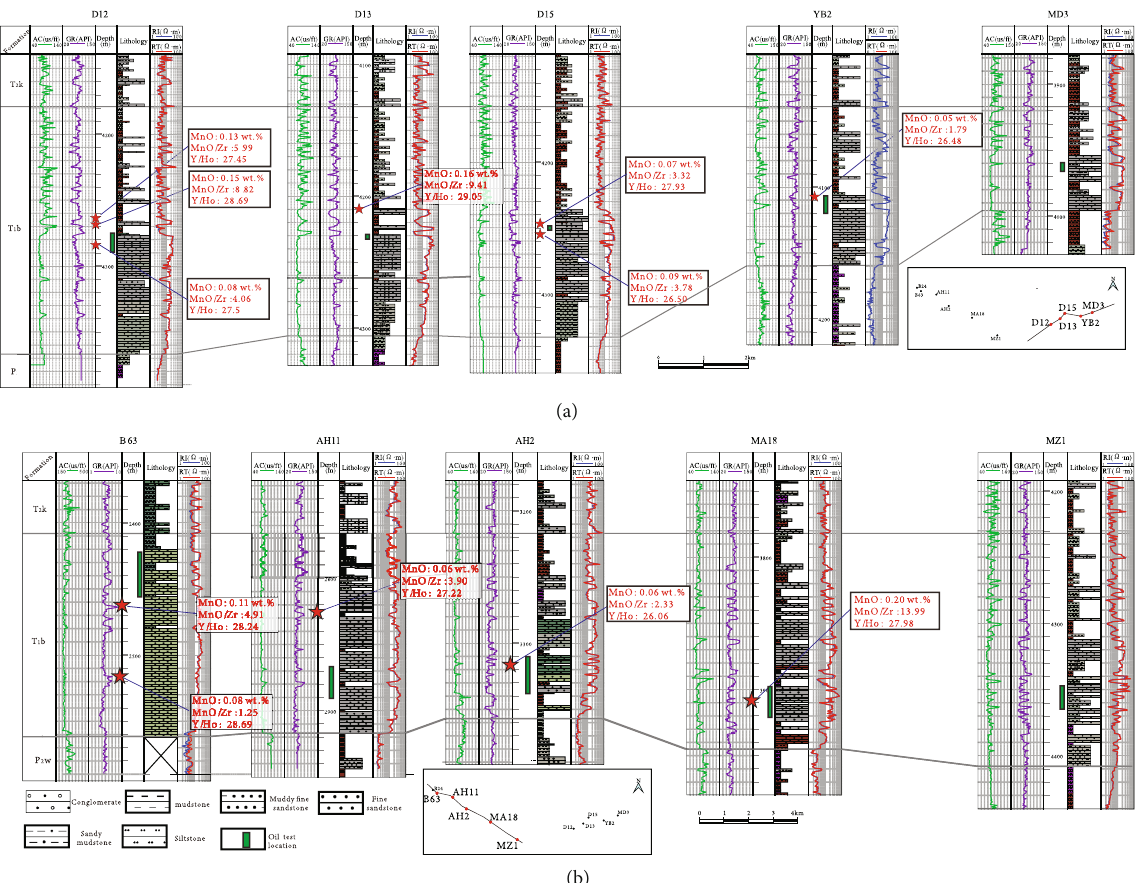
Figure 9: (a) D12-D13-D15-YB2-MD3 tracing indicators (MnO, MnO/Zr, and Y/Ho) that connect the well pro fi les. (b) B63-AH11-AH2- MA18-MZ1 tracing indicators (MnO, MnO/Zr, and Y/Ho) that connect the well pro fi